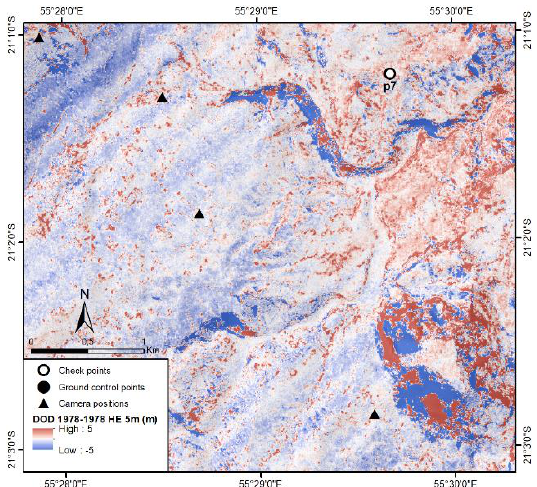
Figure 10. Difference of DEM at 5 m resolution (1978 all cameras DSM – 1978 high elevation DSM). Flight line artefact appear again in a NW-SE direction. Elevation oscillation stripes striking SW-NE also occur (see Figure 9) at a wavelength of 200 - 500